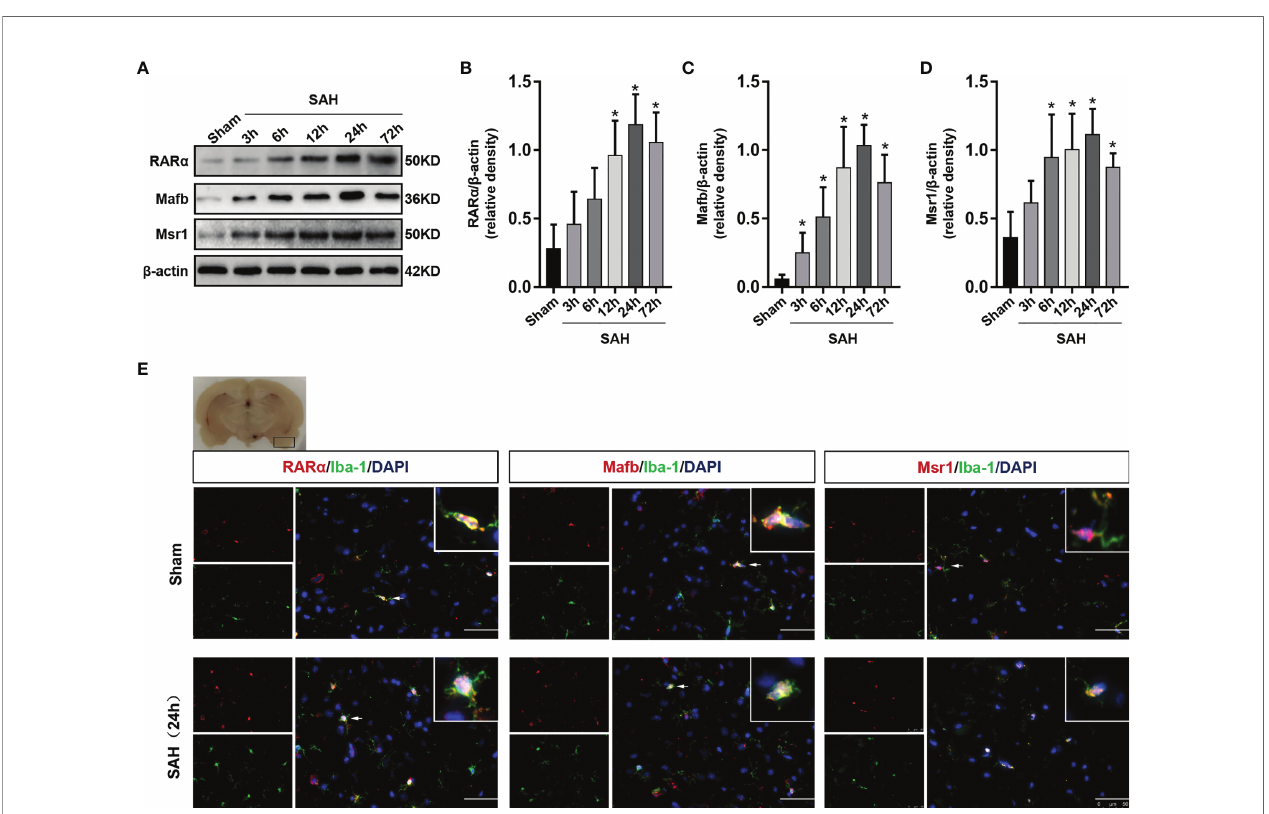
FIGURE 2 | Expression changes of RAR a , Mafb and Msr1. (A – D) Representative Western blot bands of time course and quantitative analyses for RAR a , Mafb, and Msr1. n = 6 per group. * P < 0.05 vs Sham group. (E) Representative images of double immuno fl uorescence staining for RAR a , Mafb and Msr1 with microglia at 24 h after SAH. n = 3 per group. Scale bar = 50 m